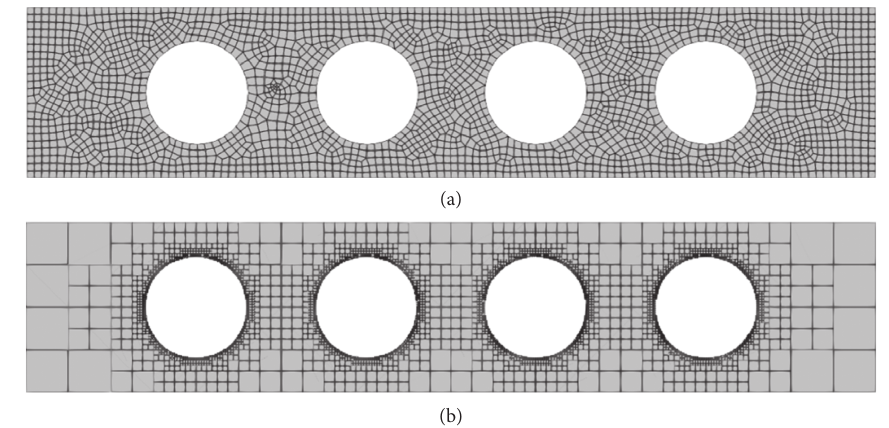
Figure 8: Elements of a multihole panel: (a) Abaqus CPS4 elements and (b) quadtree elements.